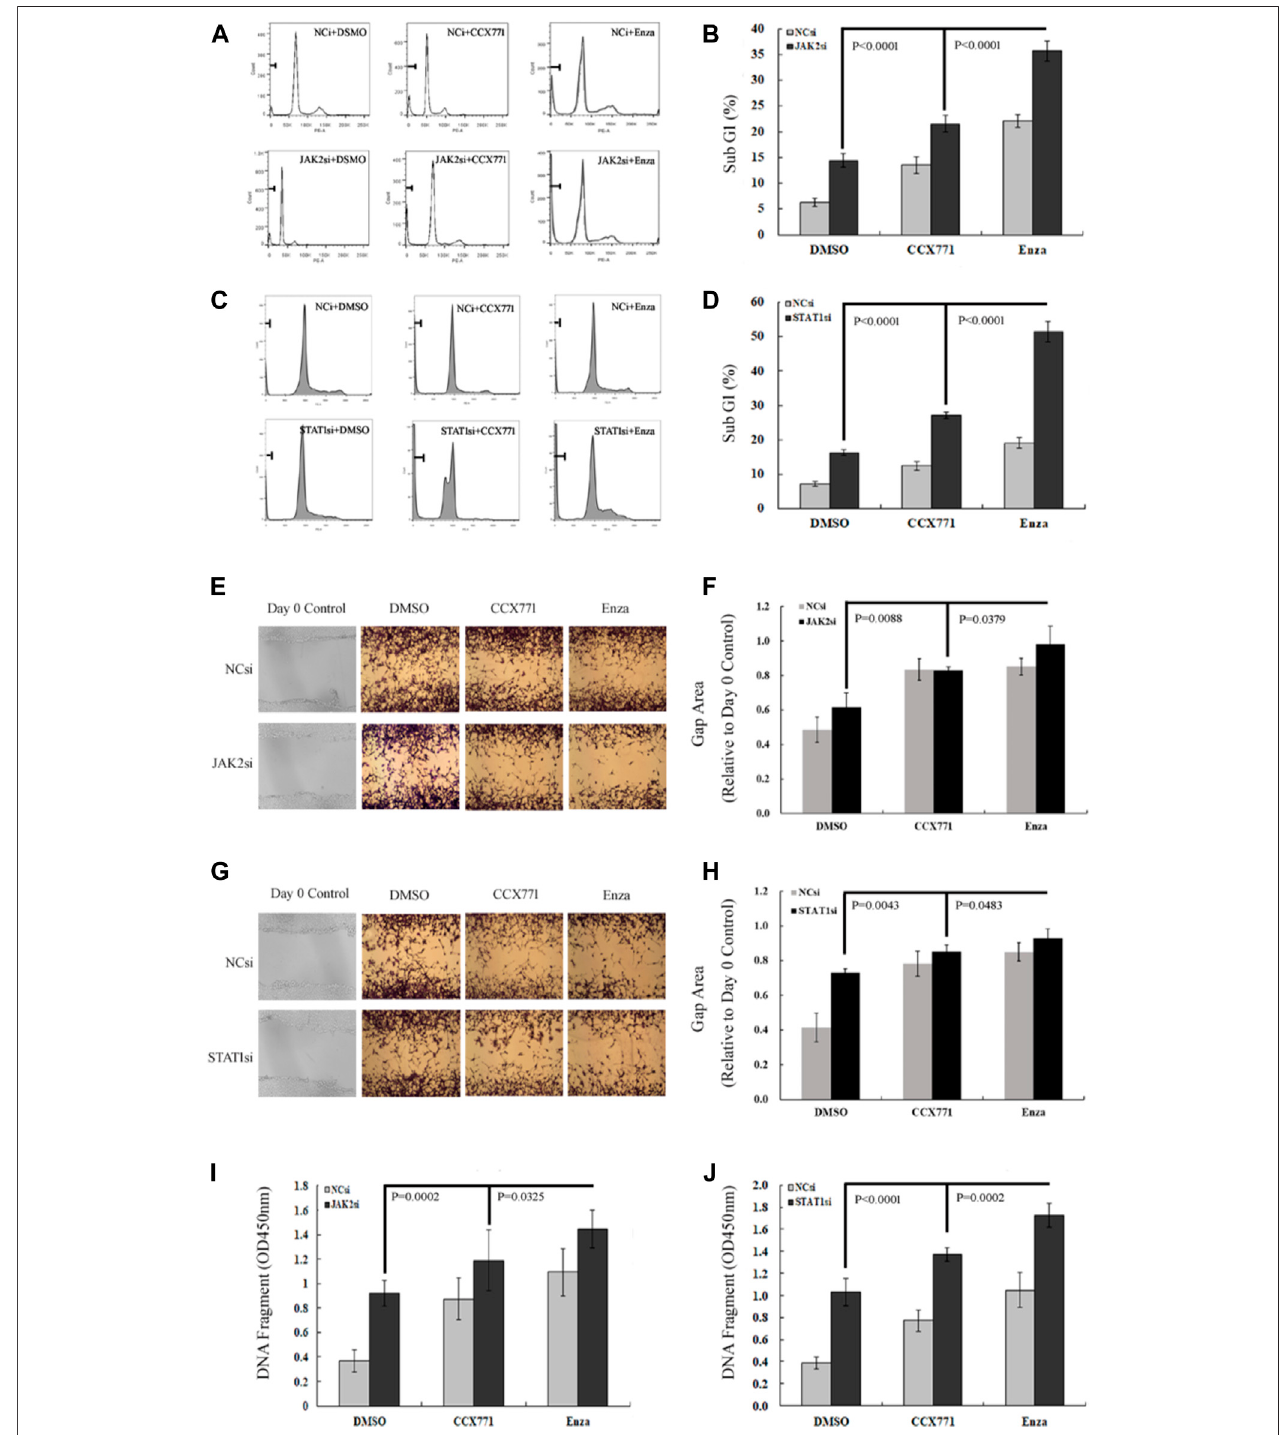
FIGURE 4 | ENZ + JAK2/STAT1si synergistically suppressed survival, migration, and DNA damage repair of CRPC cells. (A,B) Flow cytometry demonstrated that single-agent JAK2si treatment remarkably increased the percentage of sub-G1 cells, and the combination treatment of ENZ + JAK2si showed a signi fi cantly superior effectcomparedwithsingle-agentJAK2sitreatmentandthecombinationtreatmentofCCX771+JAK2si. (C,D) Similarly,STAT1sisigni fi cantlyincreasedthepercentage of sub-G1 cells, and the combination treatment of ENZ + STAT1si also showed a much greater effect compared with single-agent STAT1si treatment and the combination treatment of CCX771 + STAT1si. (E,F) Wound-healing assay results showed that the combination treatment of ENZ + JAK2si could reduce migration compared with single-agent JAK2si treatment and the combination treatment of CCX771 + JAK2si. (G,H) Wound-healing assay results showed that the combination